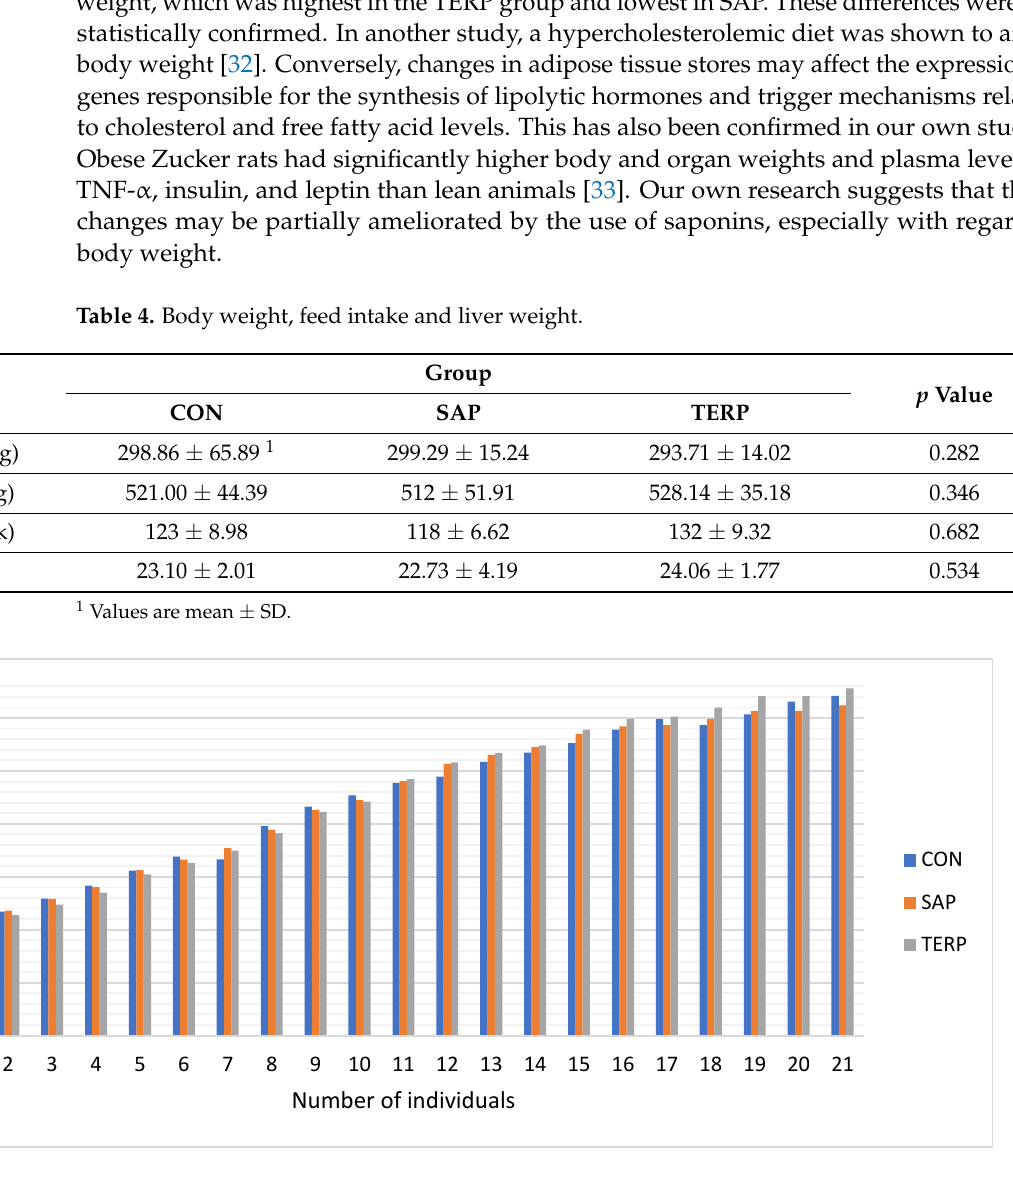
Figure 1. Weight changes after using saponins and terpenoids over a period of 8 weeks . Table 4. Body weight, feed intake and liver weight.